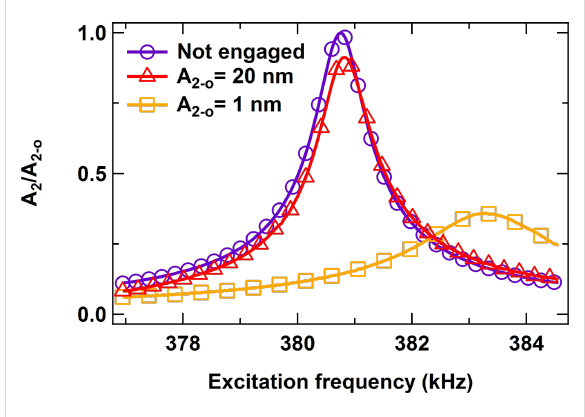
Figure 5: Simulation of the change in frequency response for the second eigenmode of a cantilever with fundamental eigenfrequency of 60.8 kHz (Q ≈ 150), second eigenfrequency of 380.8 kHz (Q ≈ 450), and fundamental force constant 1.6 N/m as a function of the second eigenmode’s free oscillation amplitude. The fundamental free oscilla- tion amplitude and amplitude setpoint are 100 nm and 70%, respect- ively. The sample is a soft dissipative polymer [13]. The graph illus- trates the increased sensitivity of the second eigenmode as its free amplitude drops from 20 nm to 1 nm. In the former case the frequency shift and decrease in response amplitude are small compared to the free response. In the latter case, the eigenmode is much more sensi- tive, leading to a significantly larger frequency shift and much smaller oscillation